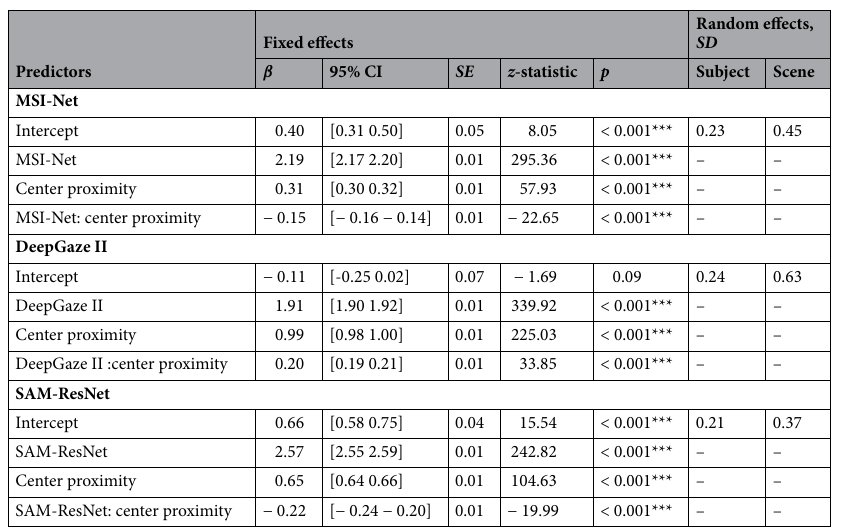
Table 1. Logistic general linear mixed effects model results for each deep saliency model: MSI-Net, DeepGaze II, and SAM-ResNet. Beta estimates ( β ), 95% confidence intervals (CI), standard errors (SE), z − statistic, and p -values ( p ) for each fixed effect and standard deviations ( SD ) for the random effects of subject and